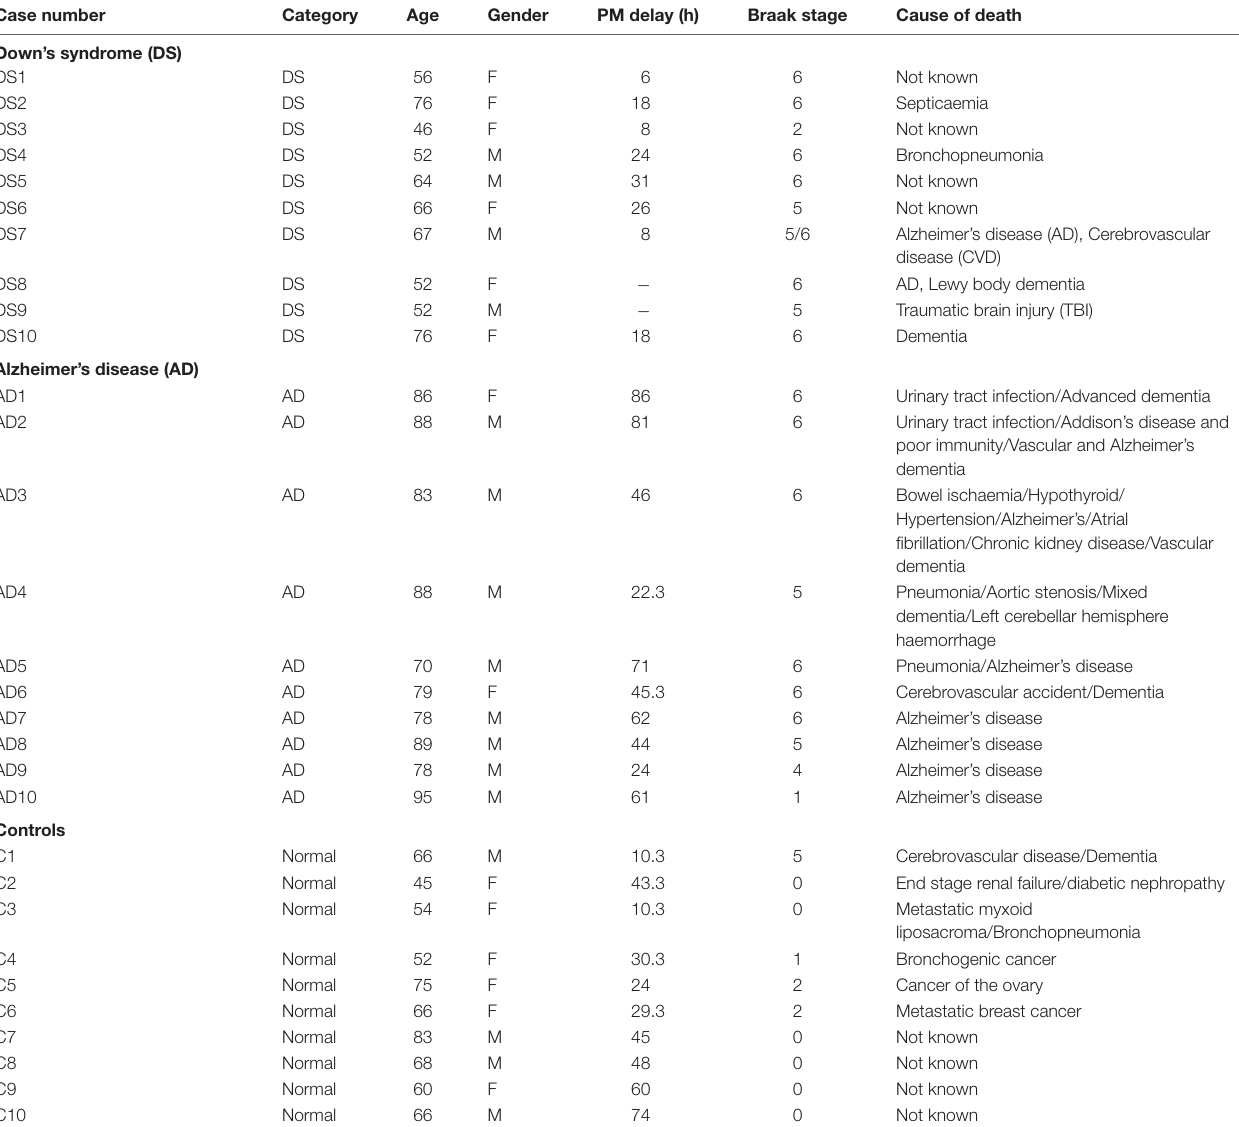
TABLE 1 | Characteristics of post-mortem brain samples of Alzheimer’s disease (AD), Down’s syndrome (DS) and age-matched control study population, showing age, gender, post-mortem time delay, Braak stage and cause of death. Case number